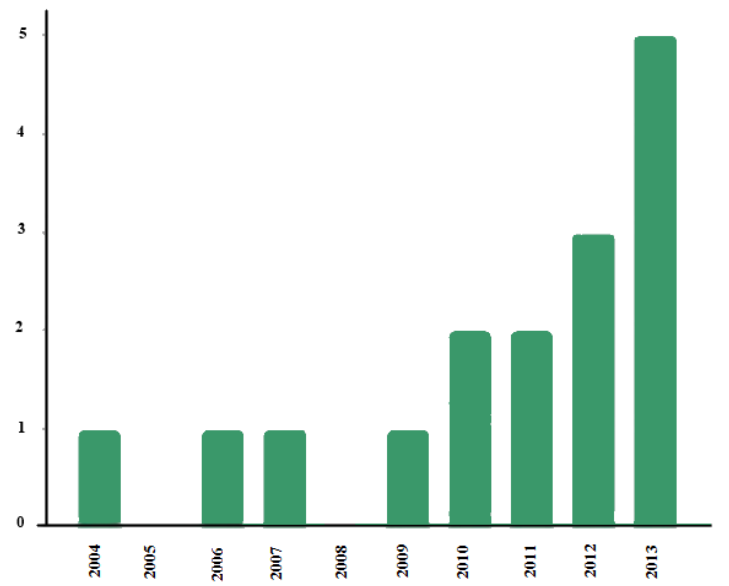
Figure 3. Graph of studies on telehealth and